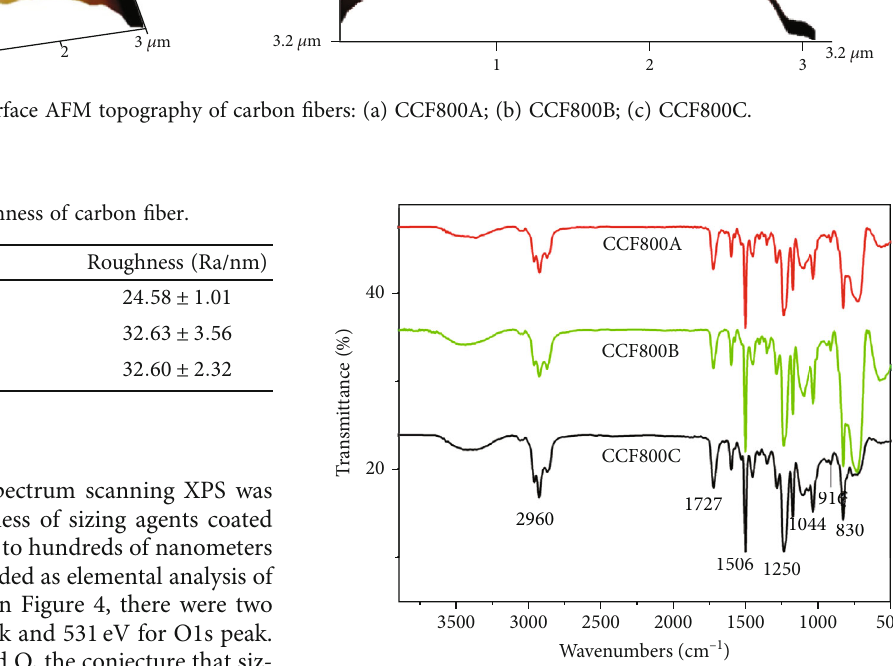
Figure 3: The Fourier transform infrared spectra of